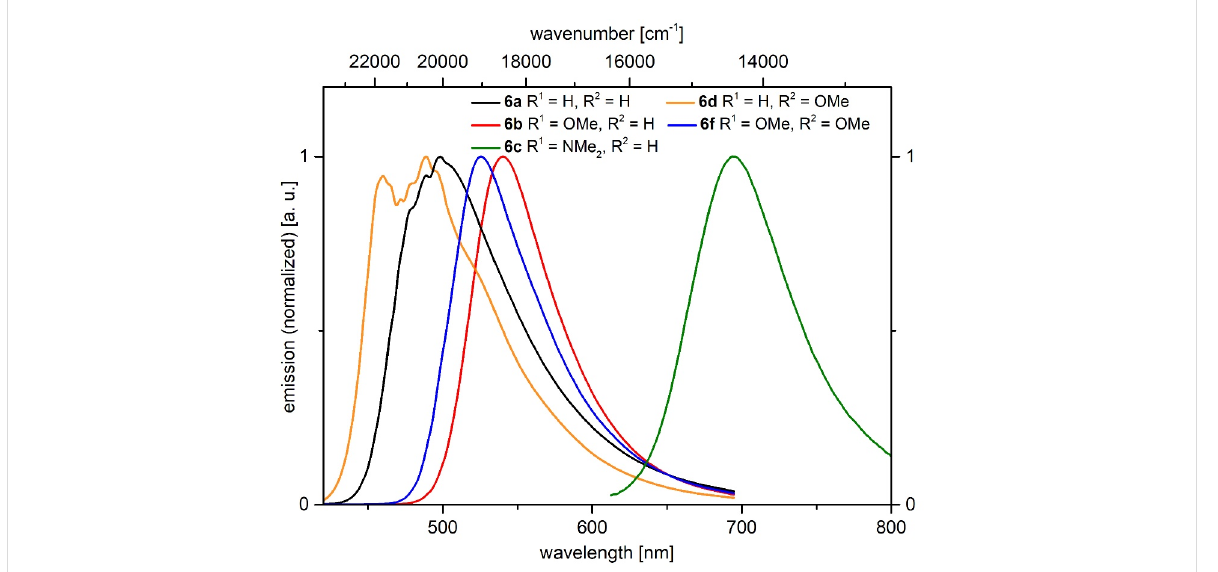
Figure 14: Normalized emission spectra of selected α -pyrones 6a–d , f in the solid state at T = 298 K.